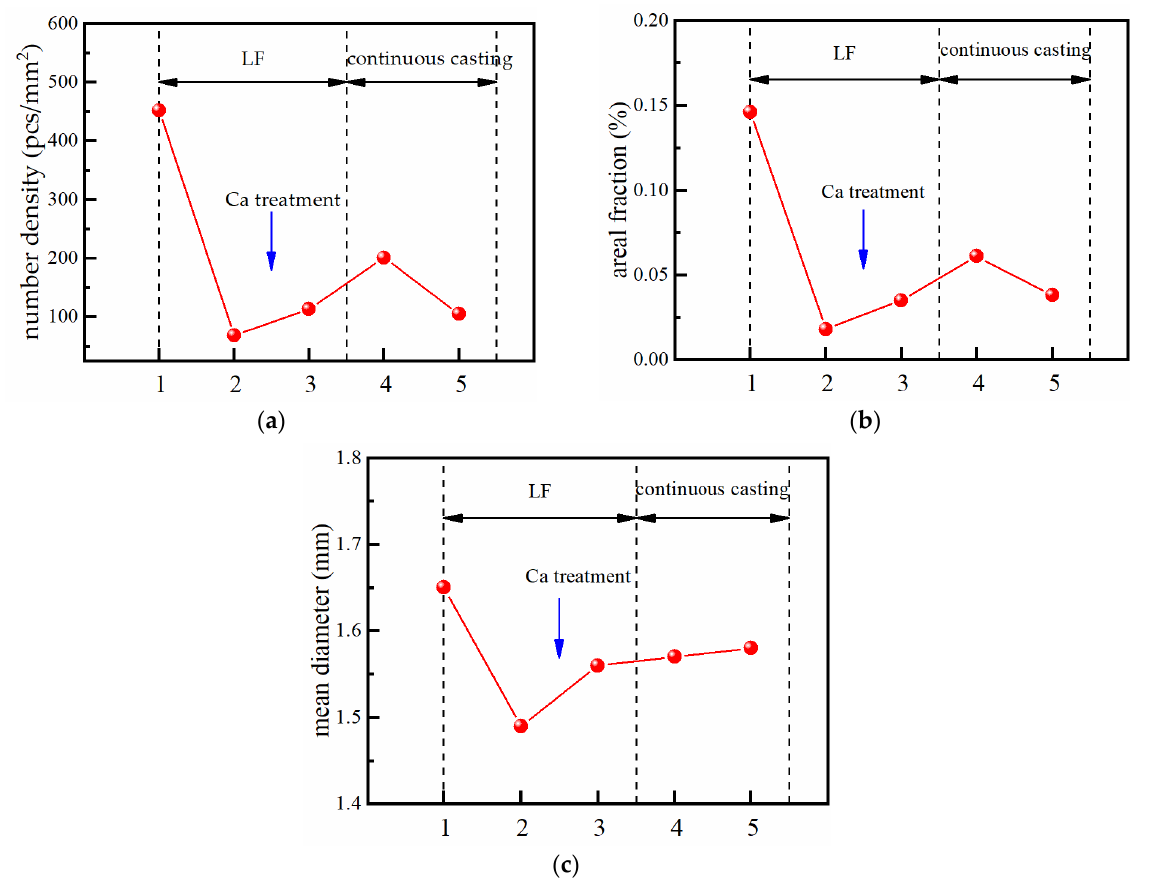
Figure 3. Changes in the number density, average size distribution, and areal fraction of inclusions in each process. ( a ) Number density of inclusions; ( b ) areal fraction; ( c ) size distribution.